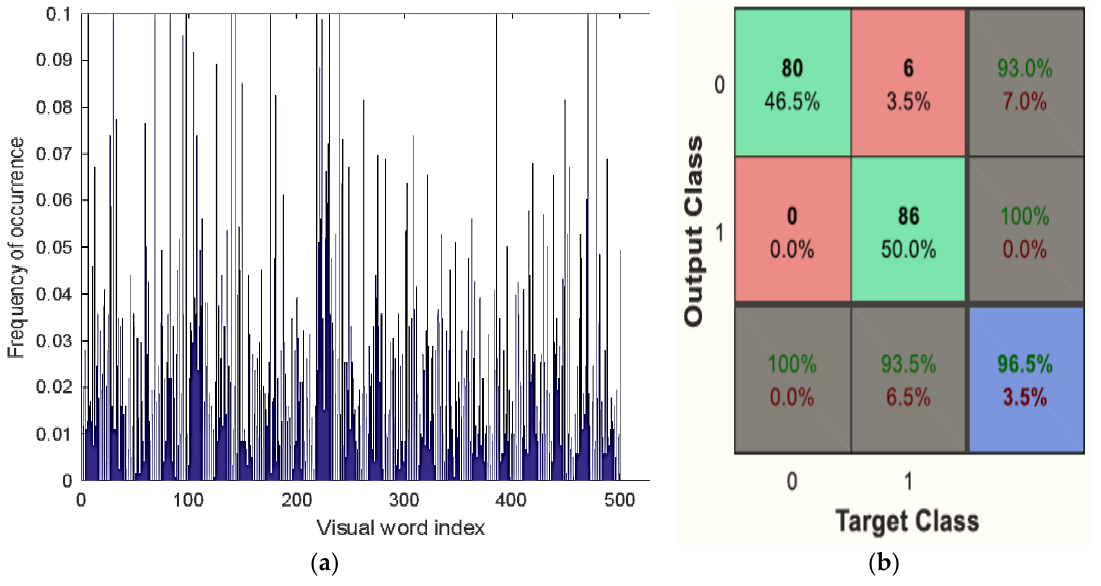
Figure 11. ( a ) Visual vocabulary of BoVW classifier, ( b ) Confusion matrix of BoVW classifier.